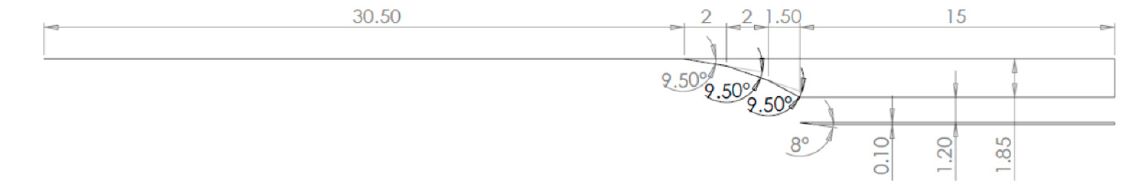
Figure 9. Three ramp inlet schematic (dimensions in metres).